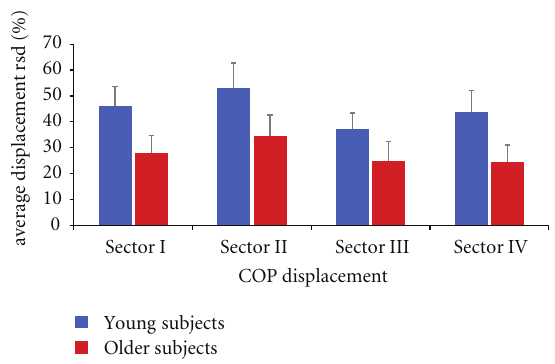
Figure 3: Bar charts indicate group data of young (blue bars) and older subjects (red bars) as assessed in subtest 8 (rotational displacement of COP). Error bars depict standard deviation. Displacement of COP was higher for young subjects as compared to older subjects for every sector ( t -test, P ≤ . 001).